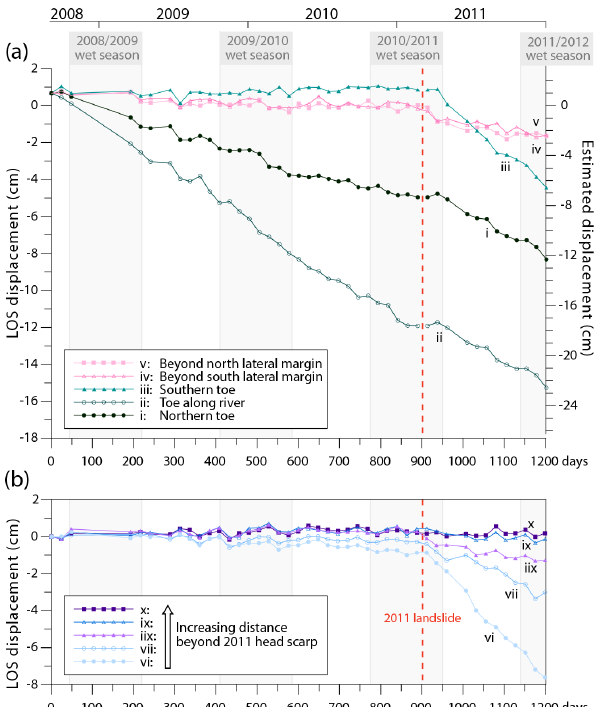
Figure 9. Displacement time series from the Pampahasi area (loca- tions i to x in Fig. 8). (a) Movement of the west slope of the Río Irpavi valley within the area affected by the 2011 landslide (i–iii) and adjacent paleolandslide deposits (iv–v). The right axis is ap- proximate, given that additional error is introduced from conversion from LOS to true motion. (b) Movement on Pampahasi Plateau be- hind the head scarp of the 2011 landslide (vi–x). Variability in the data, which is most pronounced in parts of the time series with low displacement rates, indicates phase noise resulting from factors un- related to ground motion. Displacements between the end of the pre-failure stack and the start of the post-failure stack are not pre- cisely constrained within the limits of the 2011 landslide (i–iii). For the Pampahasi slope adjacent to the 2011 failure and for the Pampa- hasi Plateau, displacements between the stacks are based on results of full-stack processing (see Sect. S4.8).